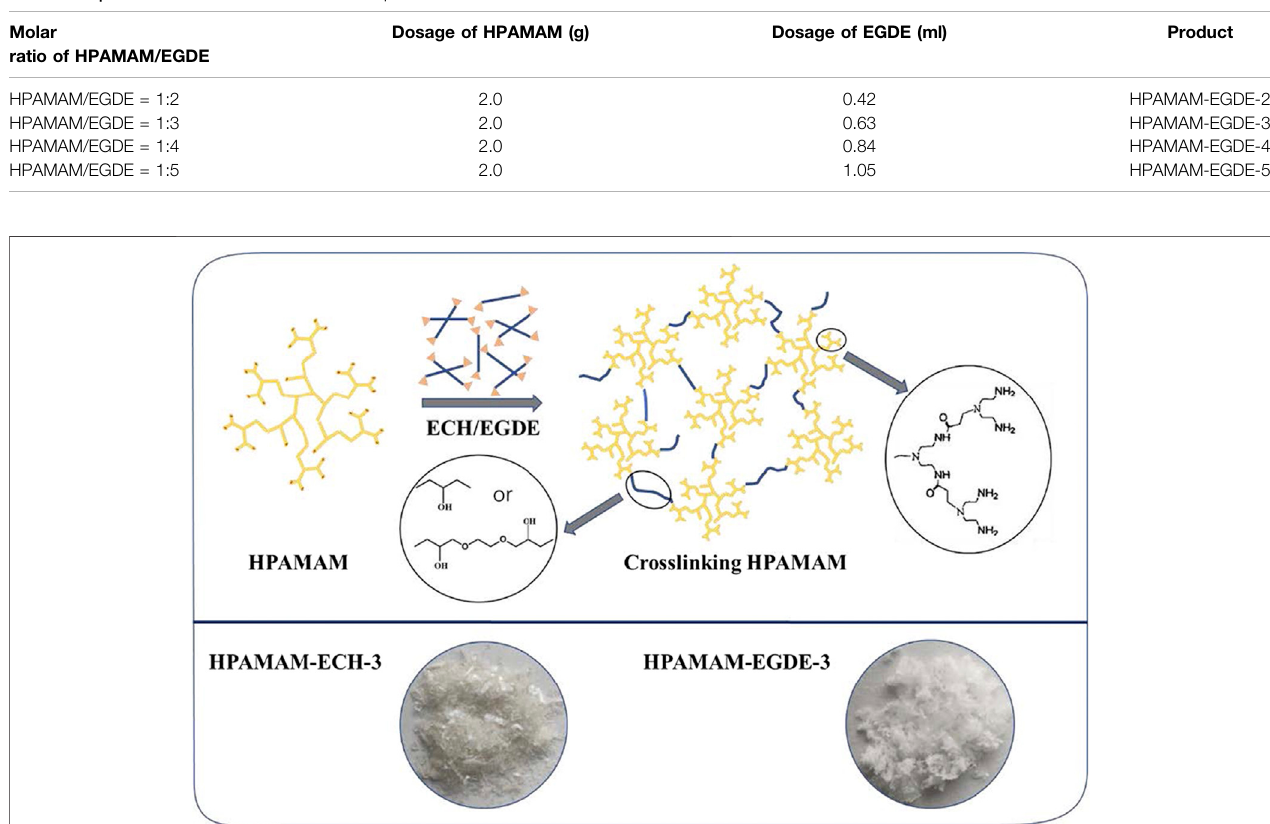
TABLE 1B | Formulation of HPAMAM-EGDE samples. Molar ratio of HPAMAM/EGDE